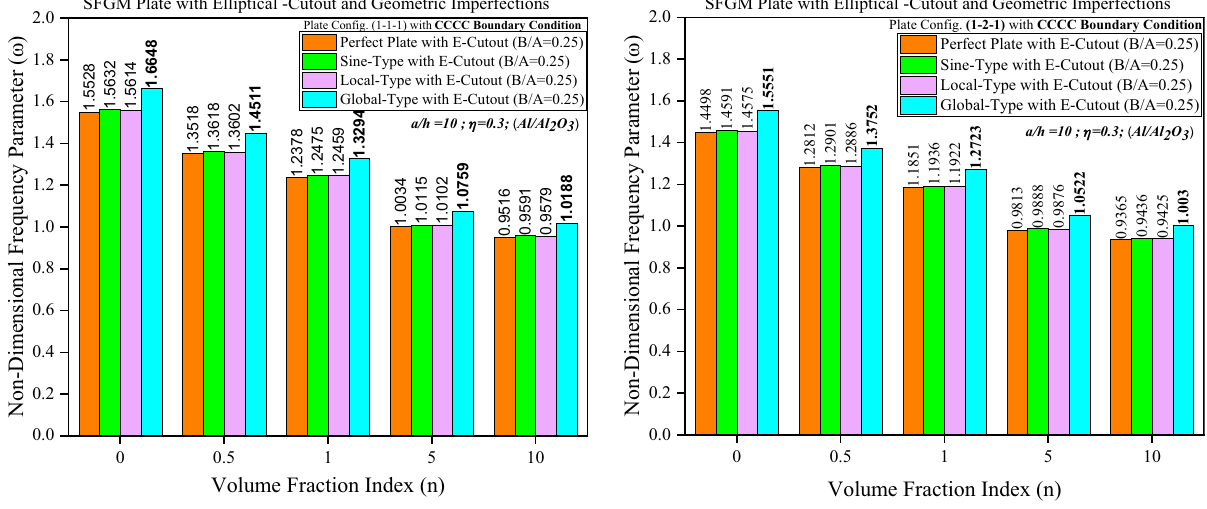
Figure 15: E ff ect of geometric imperfections and CCCC boundary condition on the NDFP of the SFGM plate with elliptical cutouts using ( 1 - 1 - 1 ) plate con fi guration with ( a / h = 10 ) and η = 0.3.